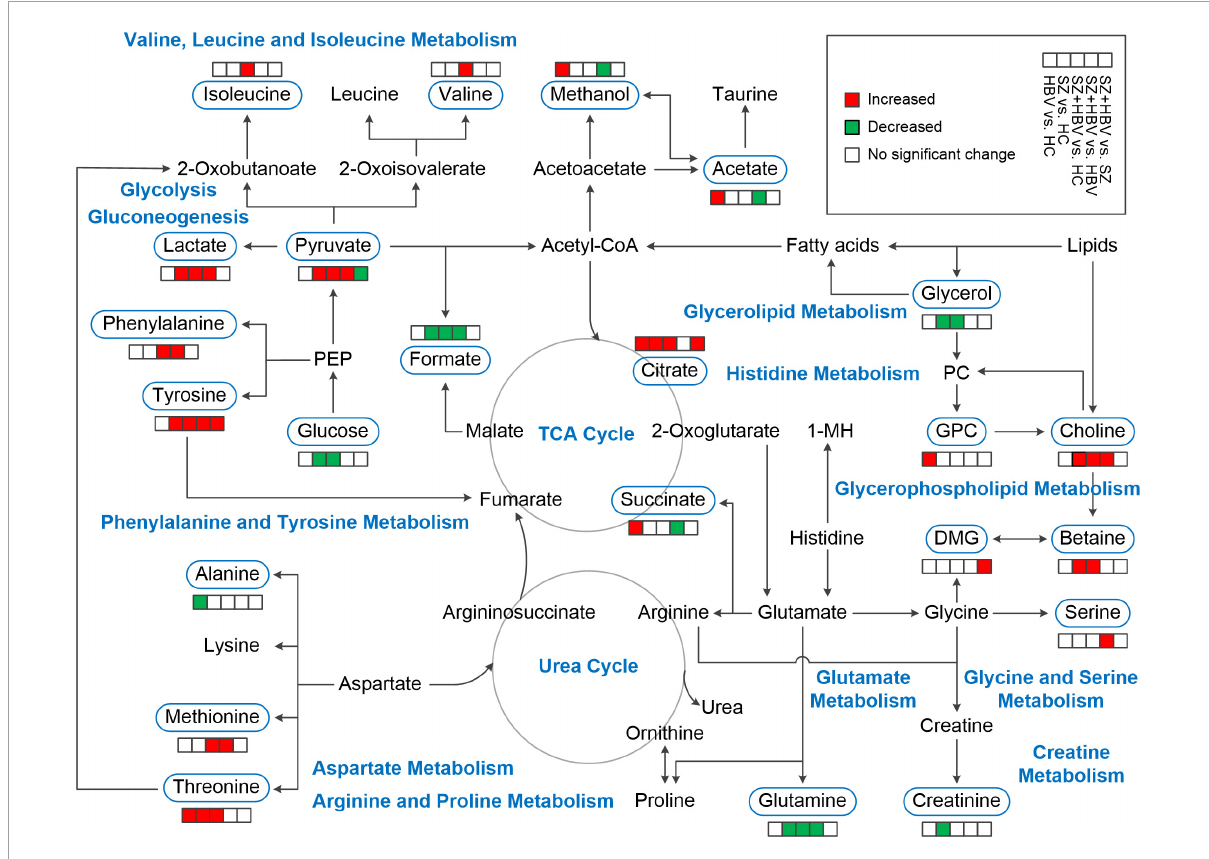
FIGURE5 Schematic overview of metabolites and major metabolic pathways. 1-MH, 1-methylhistidine; GPC, glycerophosphocholine; PC, phosphocholine; PEP, phosphoenolpyruvate; TCA, tricarboxylic